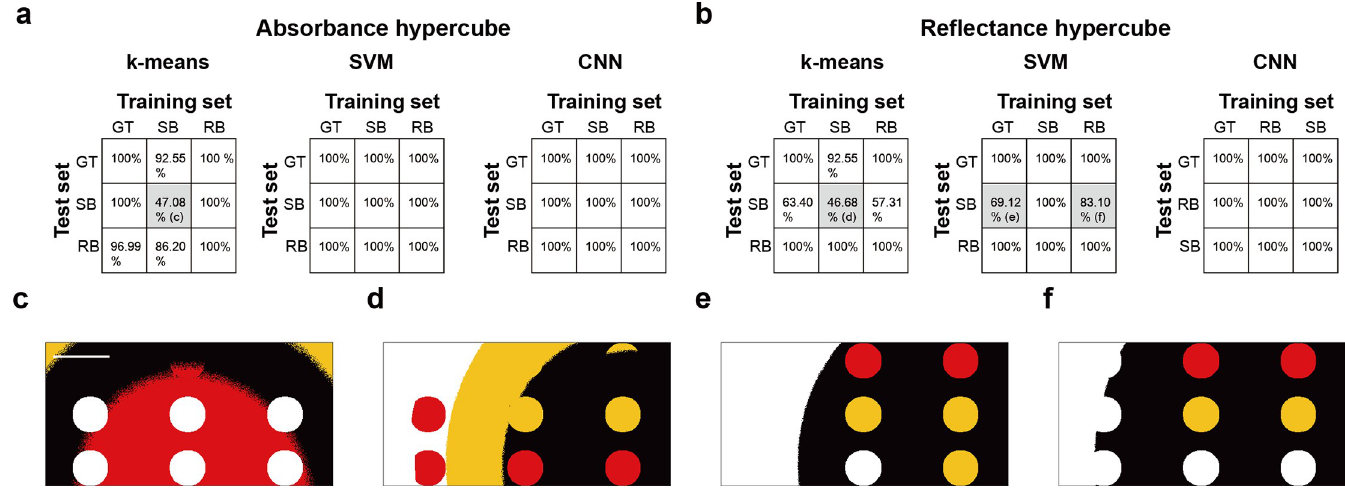
Fig 7. Investigating the effect of background correction on the accuracy of machine learning-based hyperspectral imaging classification. Classification accuracy of three machine learning methods (k-means clustering, support vector machine and convolutional neural network) in absorbance (a) and reflectance (b) hypercubes obtained by GT, SB and RB methods. (c—f) Representative images of classification results indicated by c–f in (a) and (b). Scale bar: 100 pixels.